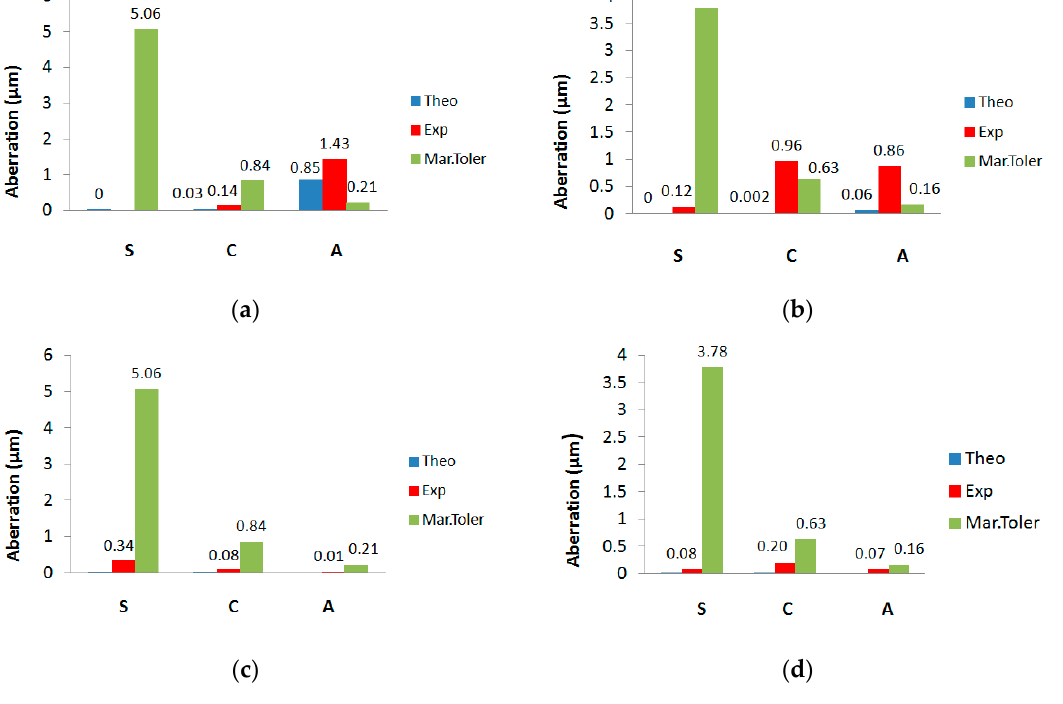
Figure 6. Theoretical and experimental Seidel coefficient spherical aberration (S), coma (C), and astigmatism (A) (blue and red), and Marechal tolerances (green) of the positive symmetrical ( a ) and ( b ), and the negative asymmetrical ( c ) and ( d ); HLs recorded at 633 nm ( a ) and ( c ), and at 473 nm ( b ) and ( d ).